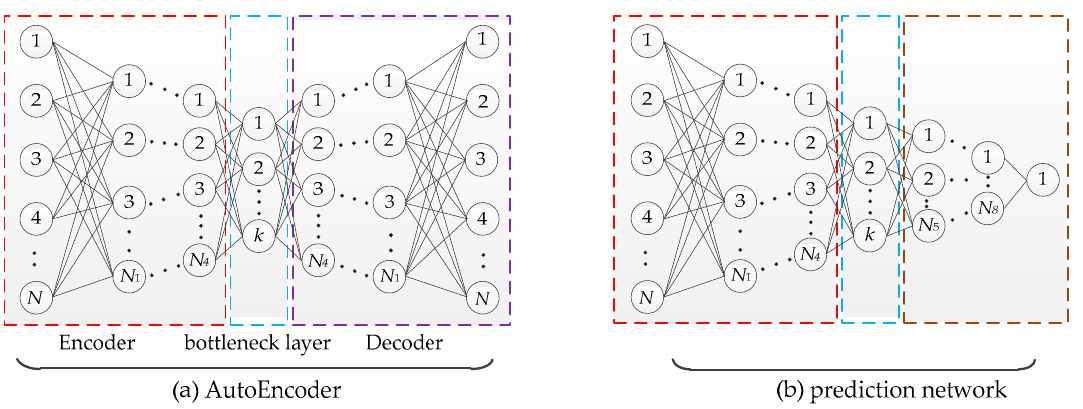
Figure 3. Structure of the utilized neural networks. ( a ) The structure of auto-encoder part network. ( b ) The structure of the prediction part network.